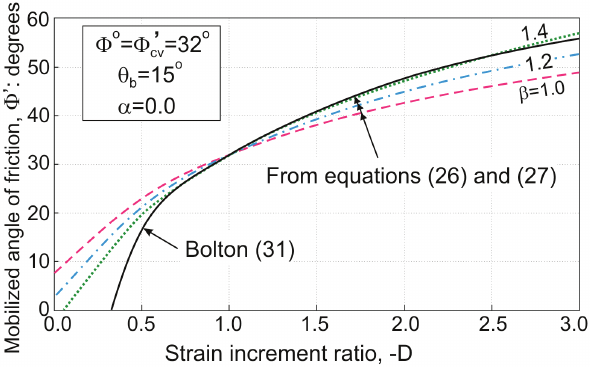
Fig. 4. Comparison of Bolton’s and the frictional state theory relationships